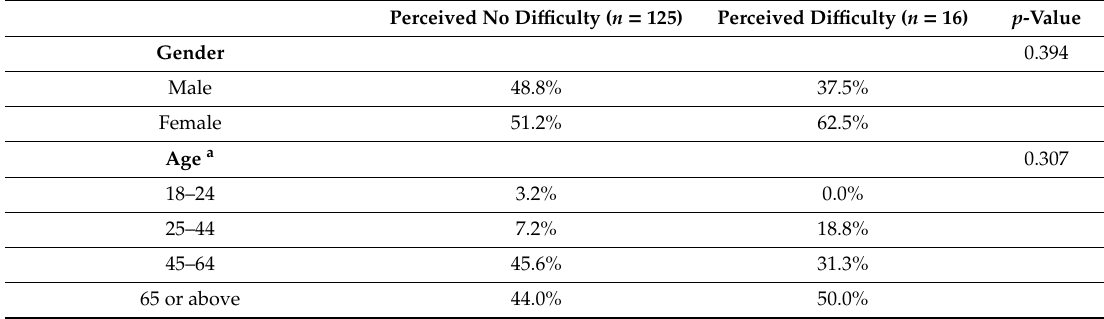
Figure 1. Difficulties reported by study samples for non-communicable diseases (NCD) management during COVID-19 pandemic ( n = 16). Table 1. Perceived difficulties for NCD management by sociodemographic factors during the COVID-19 pandemic.